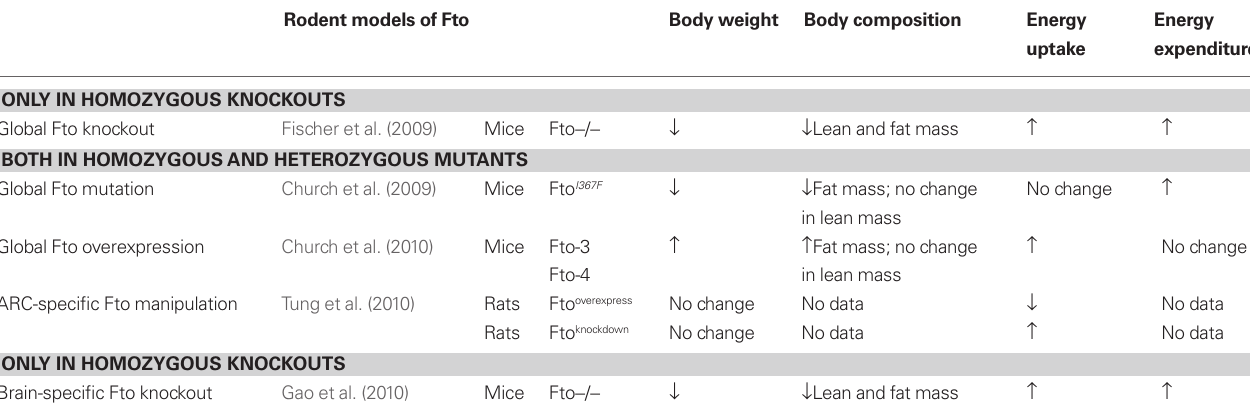
Table 1 | Summary of phenotypes from the five different Fto rodent models. rodent models of Fto Body weight Body